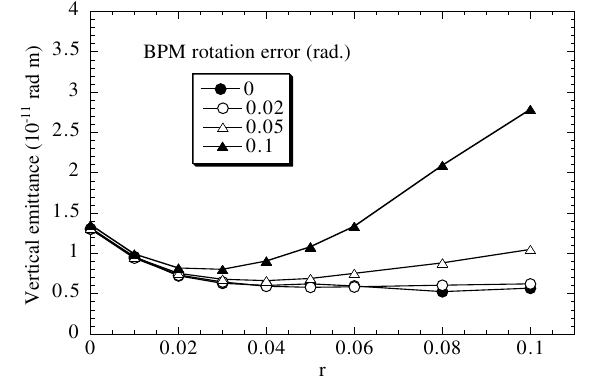
FIG. 8. (cid:26) vs r after coupling correction for different BPM y rotation errors. BPM offset error was set as 0.3 mm.